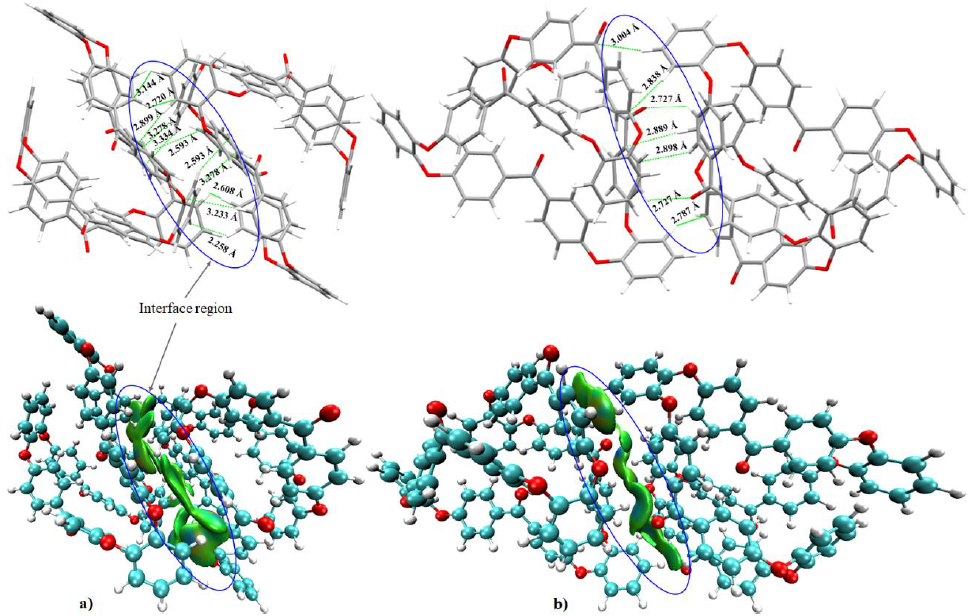
Figure 7. ( a )–( b ) (Top) The intermoelcular contact geometries and (Bottom) the IGM isosurface plots (0.005 a.u.) of two randomly selected binary complexes of o-PEEK. Selected intermolecular distances are shown. Polymers 2018 , 10 , x FOR PEER REVIEW